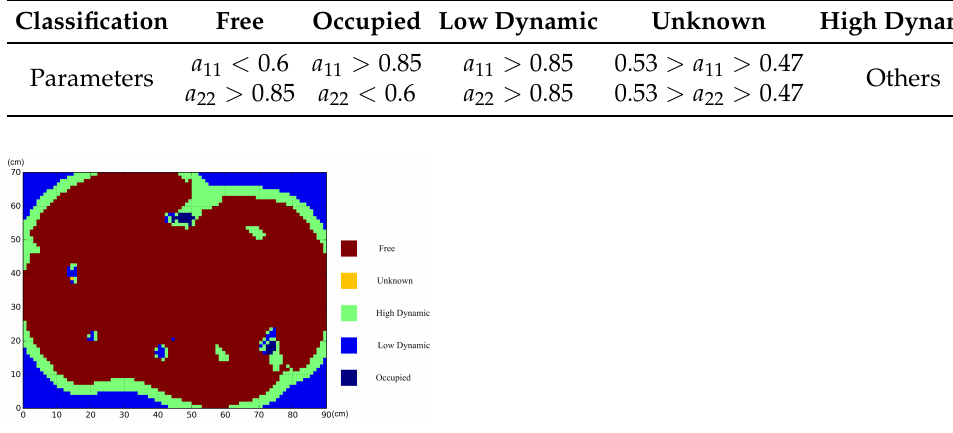
Figure 24. Classification of the results for the dynamic experimental environment. Table 3. Classification results for the dynamic experimental environment. TF = True free, TO = True occupied, FF = False free, FO = False occupied, TLD = True low dynamic, FLD = False low dynamic, THD = True high dynamic, FHD = False high dynamic, UN = Unknown.